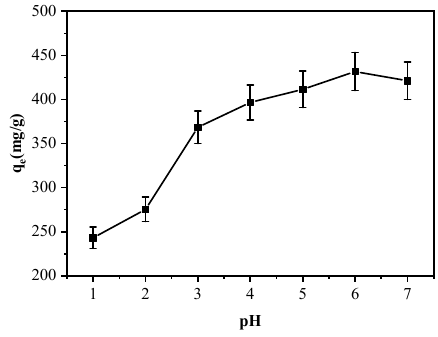
Figure 8. Effect of pH on Cu 2+ adsorption.